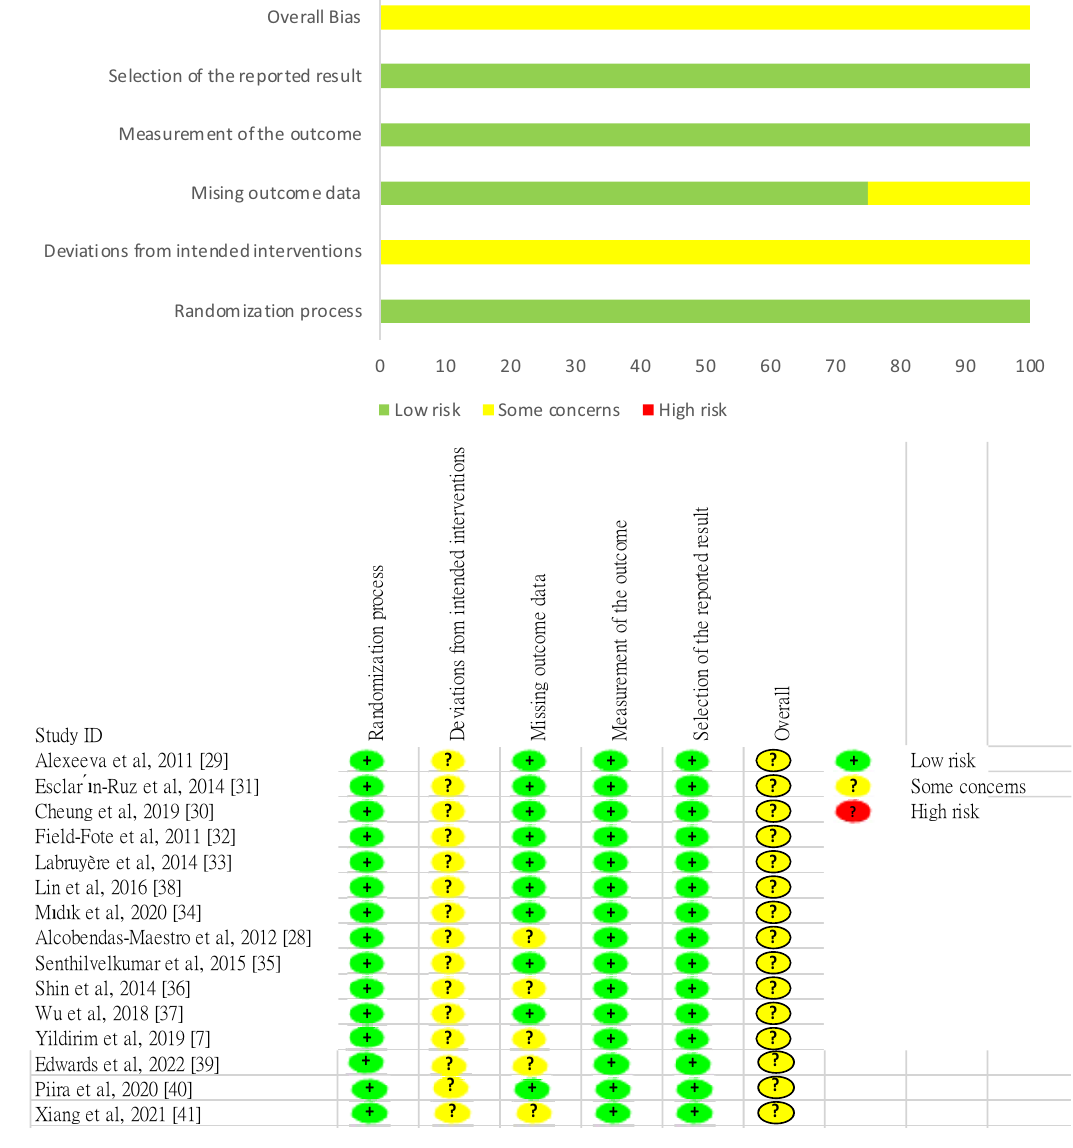
Figure 2. Study quality